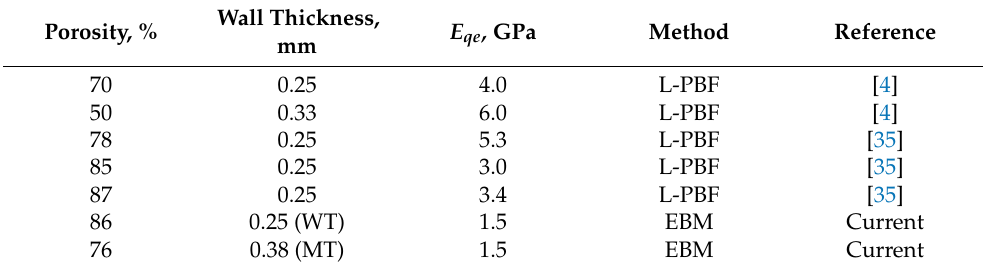
Table 4. Ti-6Al-4V sheet-based gyroid